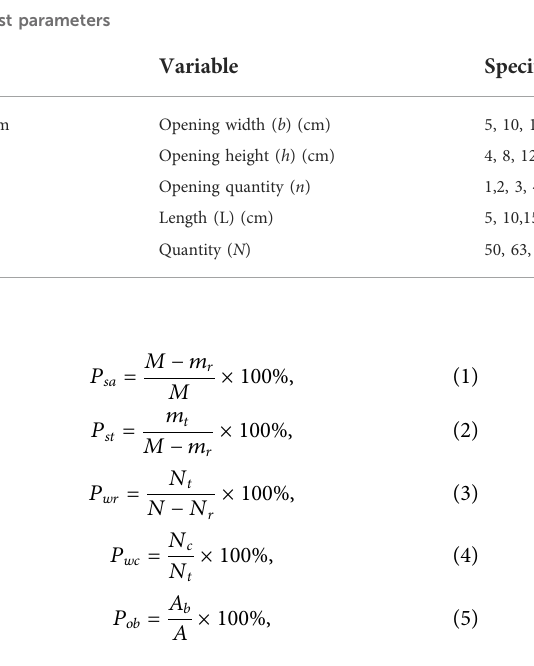
TABLE 2 Test parameters